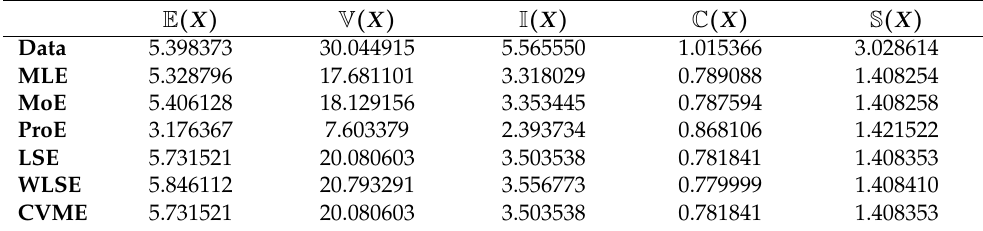
Table 11. Descriptive statistics for data set II.